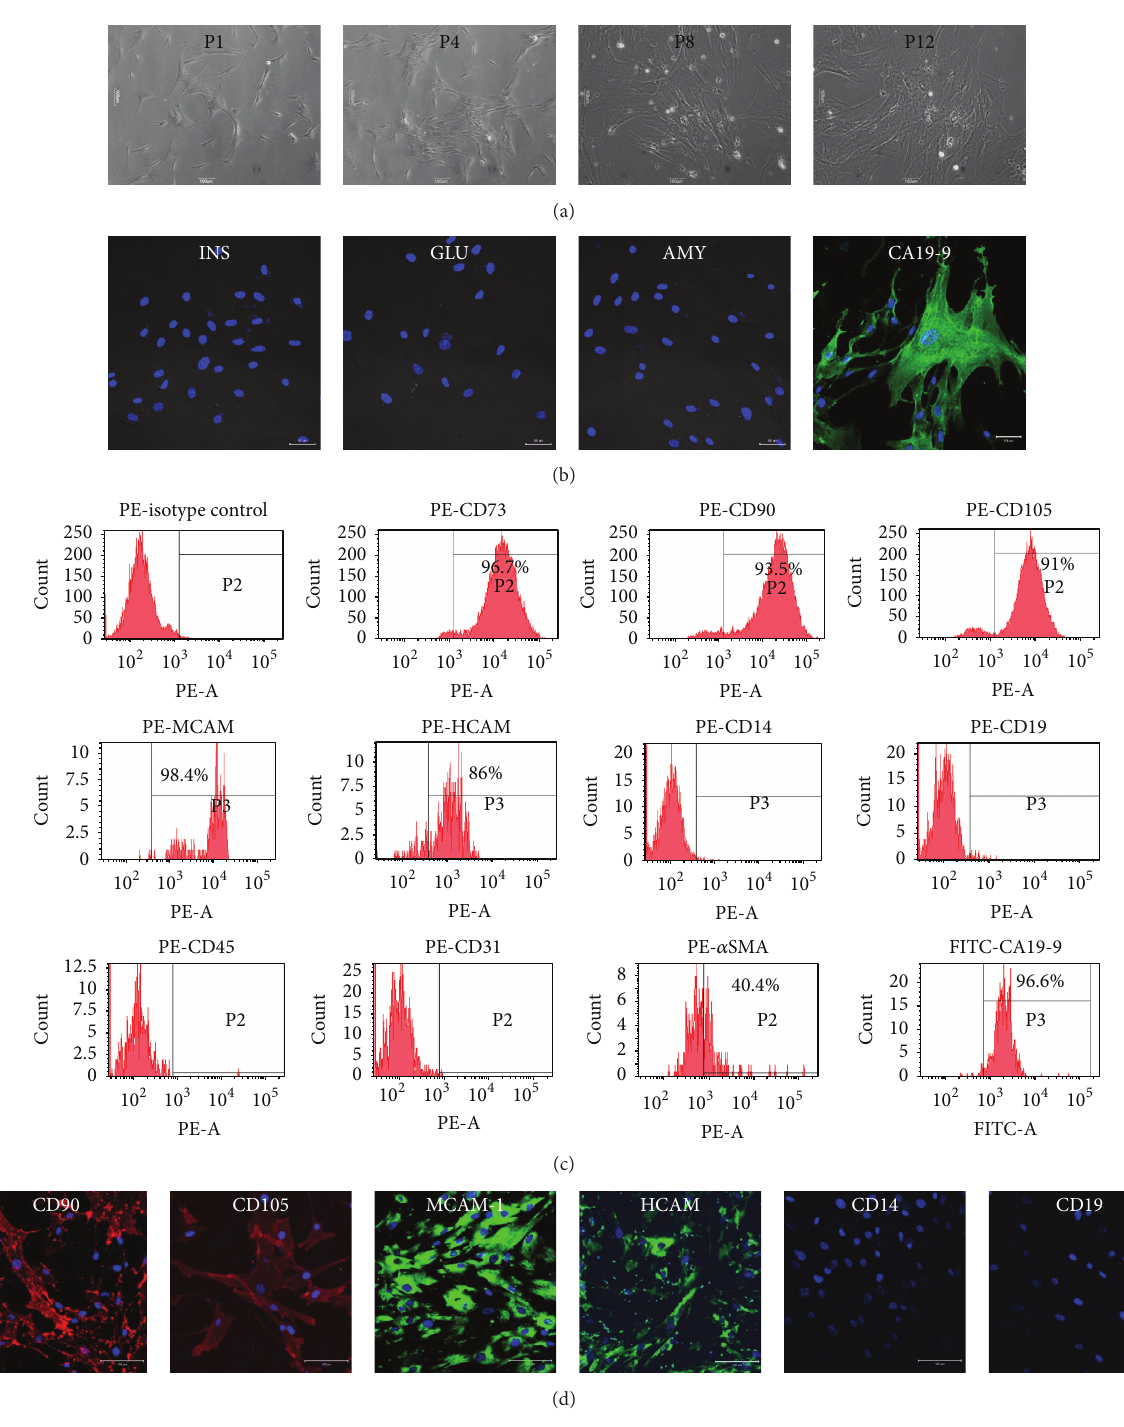
Figure 2: Phenotypic characteristics of expanded MSCs. (a) Cells with fibroblast-like morphology attached to the culture plate after the first passage of exocrine cells and maintained a similar morphology throughout continuous passages 1 through 12. (b) Passage six hpMSCs were fixed with 4% PFA and underwent immunofluorescence staining with anti-insulin, glucagon, amylase, and CA19-9. Pancreatic cell hormone insulin,glucagon, amylase, andenzymesfromexocrinecellswerenotdetected, whereasCA19-9wasdetectedinmostcells. (c)Flowcytometry analysis of fibroblast-like cells harvested at passage day 6. hMSC markers were labeled using PE-conjugated antibodies against isotypes CD73, CD90, CD105, CD14, CD19, CD45, CD31, MCAM, HCAM, 𝛼 SMA, or FITC-conjugated CA19-9. hMSC-positive markers CD73 (96.7%), CD90 (93.5%), CD105 (91%), 𝛼 SMA (40.4%), MCAM (98.4%), and HCAM (86%) were detected, and hMSC-negative markers CD14, CD19, CD45, and CD31 were not. Pancreatic duct cells positive for CA19-9 (96.9%) were also detected. (d) hMSC-phenotype markers confirmed by immunofluorescence staining. CD90, CD105, MCAM, and HCAM exhibited the strongest signals, whereas CD14 and CD19 were not detected during passage